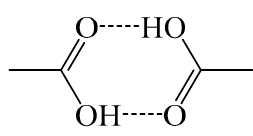
Figure 19. Structure of associated carboxylic acids.